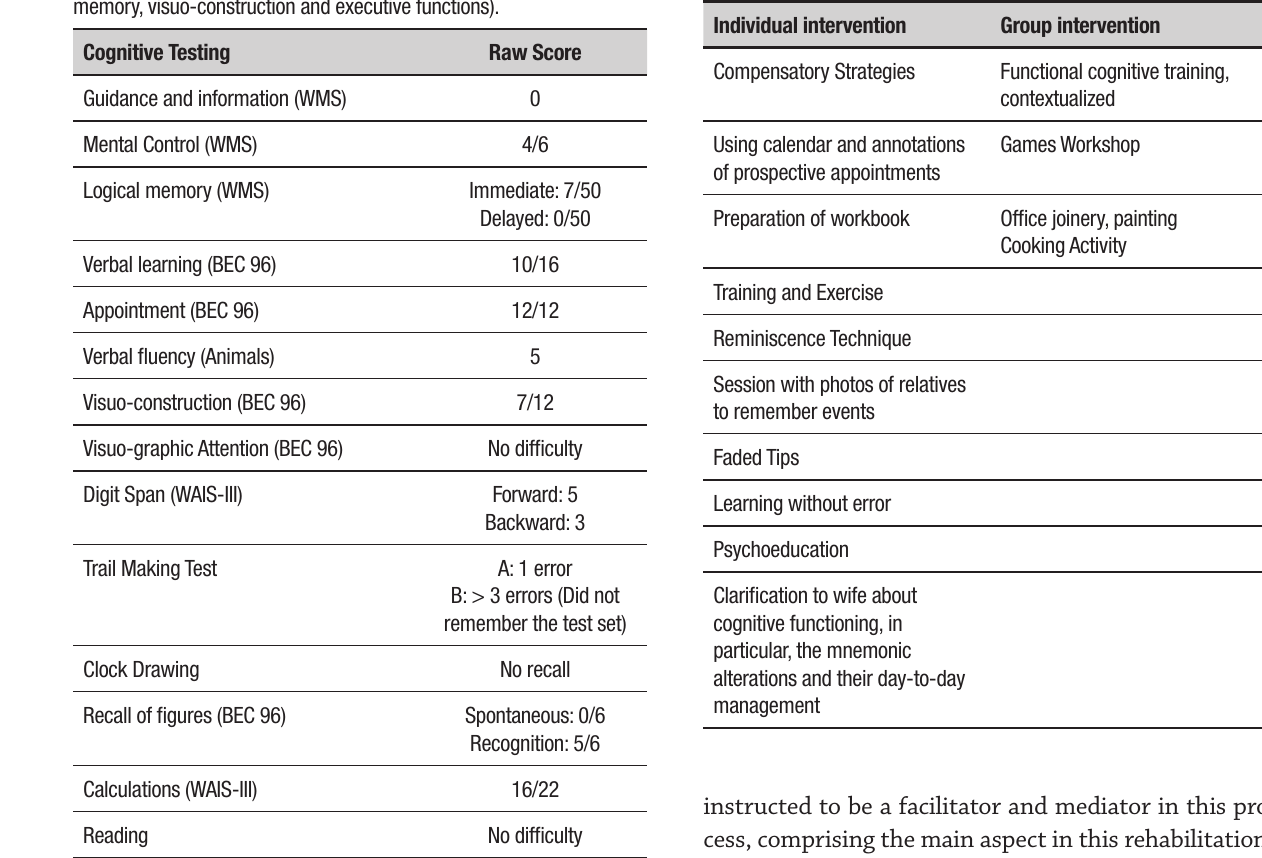
Table 2. Structuring of care (individual and group